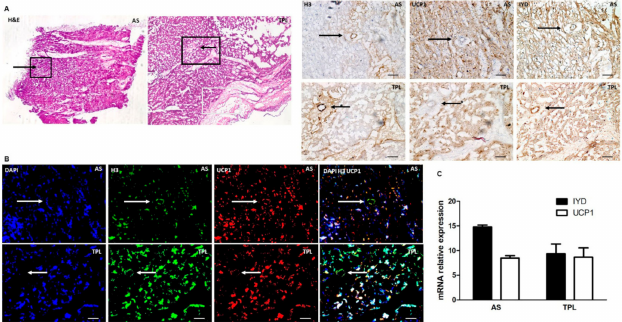
Figure 5. IYD detected by H3 Ab in human heart: ( A ) Human myocardial heart tissues from Aortic stenosis (AS) and Transplantation (TPL) patients were stained with H&E or H3 Ab, UCP1, and IYD antibodies for immunohistochemical analysis. The black boxes indicate the magnified regions analyzed in subsequent immunohistochemistry (IHC) images. ( B ) The same tissues were prepared for immunofluorescence analysis by confocal microscopy using the H3 Ab, UCP1 Ab, commercially available IYD Ab, and DAPI. Black and white arrows indicate human myocardium blood vessels. Scale bars = 100 µ m. ( C ) Total RNA was isolated from heart tissues of AS and TPL patients to confirm expression of IYD and UCP1 by qt-PCR